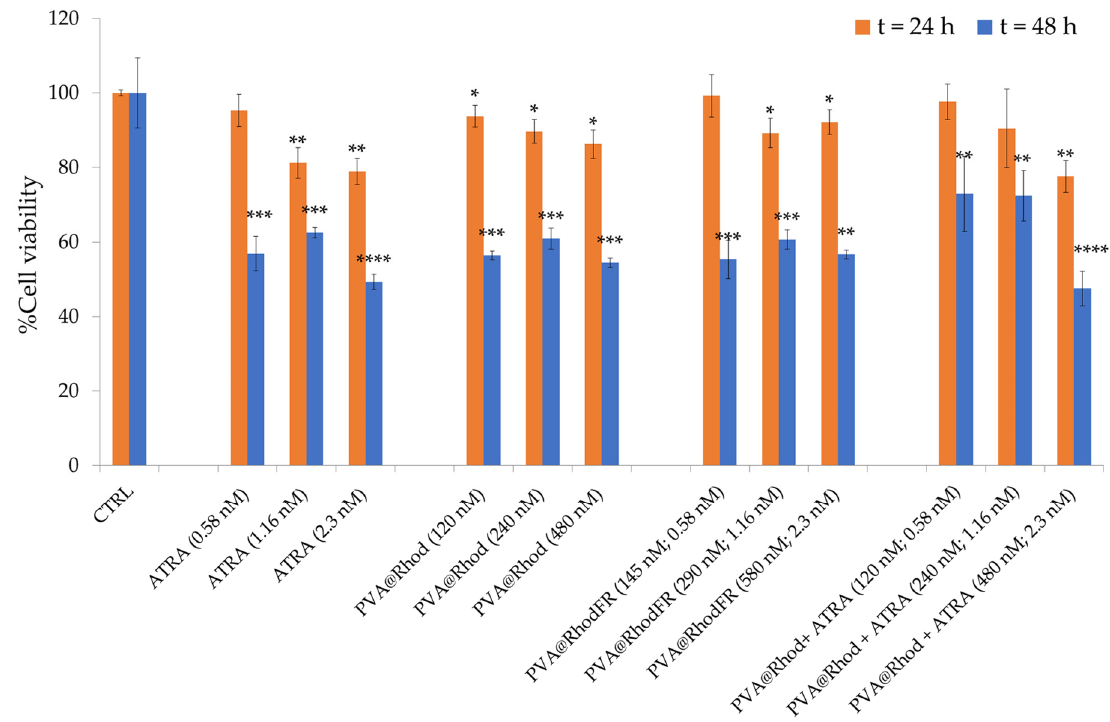
Figure 10. Cell viability assay (MTT) on SH-SY5Y cells untreated (negative control) or treated for 24 and 48 h with: ATRA (5.8×10 − 10 M, 1.16×10 − 9 M and 2.3×10 − 9 M); the fluorescent polymer PVA@Rhod (1.2×10 − 7 M, 2.4×10 − 7 M, 4.8×10 − 7 M); the functionalised polymer PVA@RhodFR (1.4×10 − 7 M, 2.9×10 − 7 M, 5.8×10 − 7 M); and the mixture PVA@Rhod + ATRA (1.2×10 − 7 M, 2.4×10 − 7 M, 4.8×10 − 7 M). The bars represent means ± S.D. of three independent experiments (S.D. = standard deviation). Statistical analysis was performed using the Student’s t -test. (*) p < 0.05, (**) p < 0.01, (***) p < 0.001, (****) p < 0.0001 vs. CTRL.